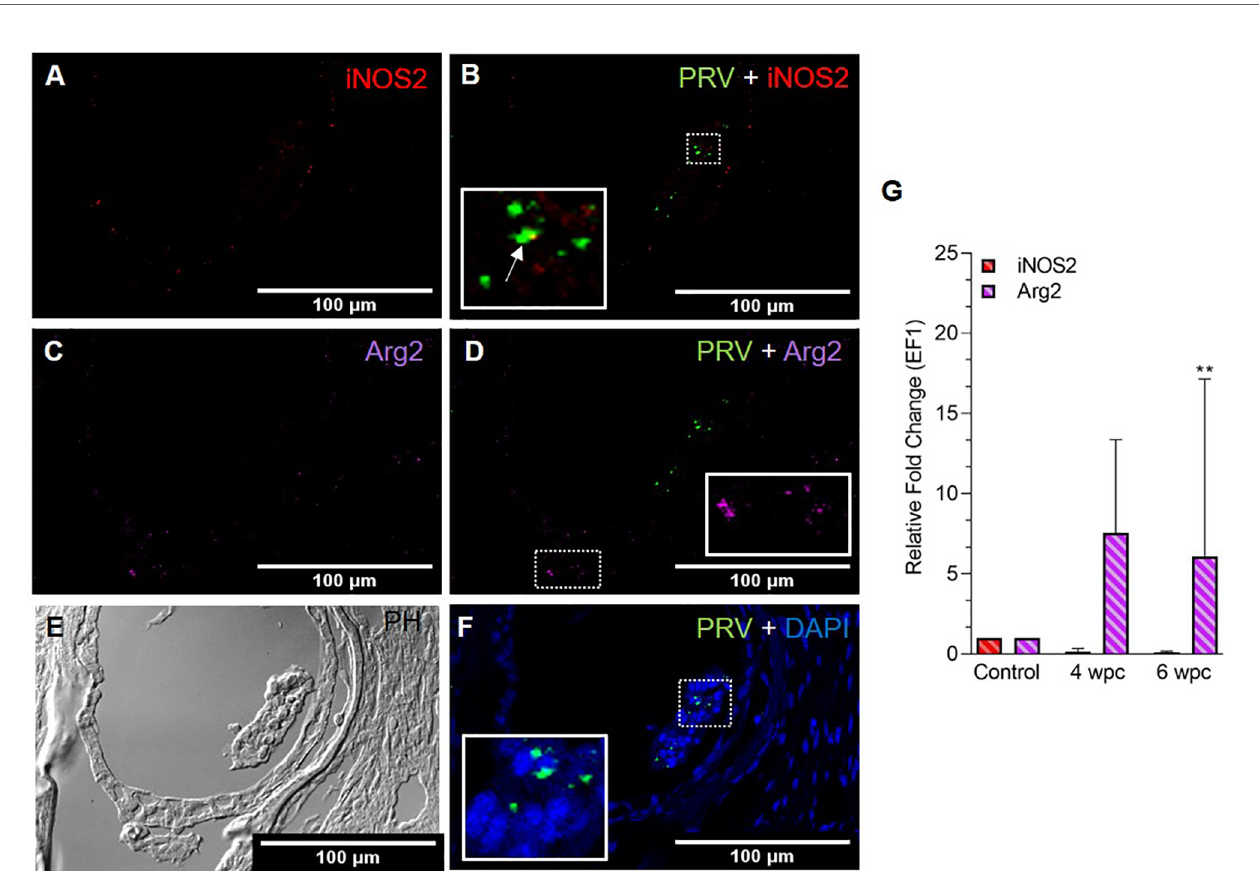
FIGURE 2 | Fluorescent in situ hybridization (FISH) of iNOS2, Arg2 and PRV-1 (A – F) in skeletal muscle at the peak of HSMI (6 wpc). (A) Few iNOS2 (red) positive M1 macrophages were detected. (B) Merged image showing co-localization (yellow in inset) of PRV-1 and iNOS2-positive M1 macrophages. (C) Sporadic presence of Arg2 (purple) positive M2 macrophages (D) Merged image does not show co-localization of PRV-1 and Arg2 (E) Phase contrast image showing aggregated blood cells in a vessel in the center. (F) A limited number of PRV-1 infected cells (green) were found (Scale Bar = 100 µm). (G) Relative fold change expression (medians) of iNOS2 and Arg2 at 4 wpc and 6 wpc normalized against EF1 a . (*) show signi fi cant difference from the control (**p <